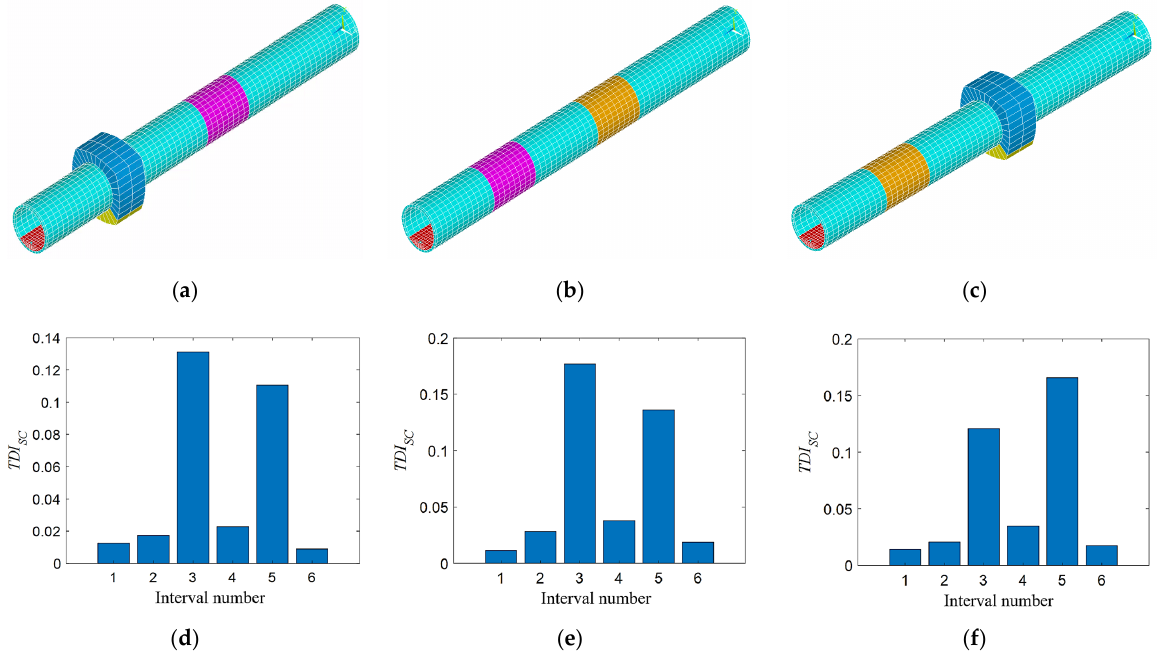
Figure 10. TDI SC index verification for different types of two damage combinations: ( a ) stiffness and void damage; ( b ) additional mass and void damage; ( c ) void and additional mass damage; ( d ) TDI SC at stiffness and void damage; ( e ) TDI SC at additional mass and void damage; and ( f ) TDI SC at additional mass and void damage.